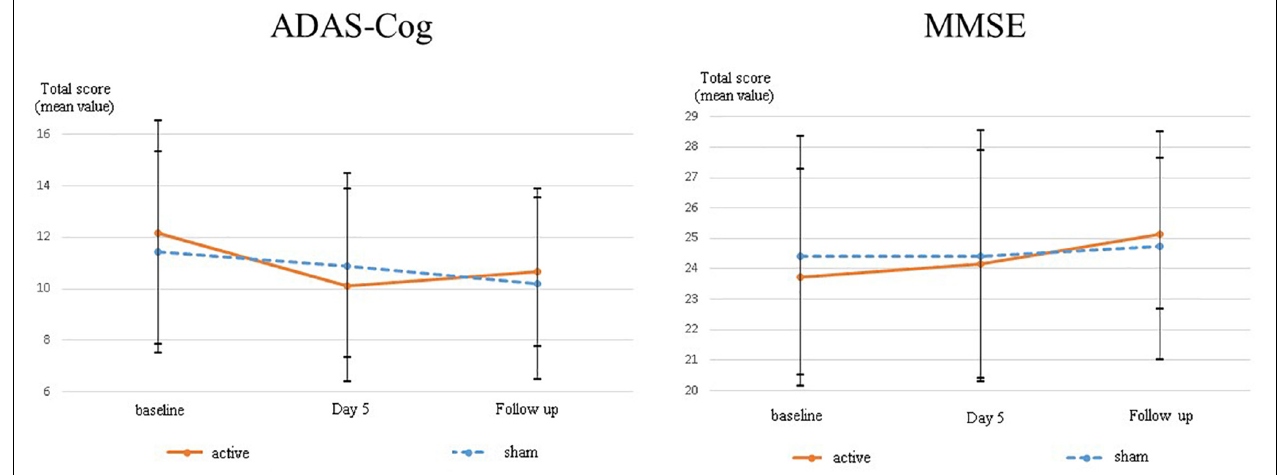
FIGURE 3 | The change scores in adjusted mean difference from baseline on ADAS-Cog and MMSE. In order to understand the mean change from baseline in each group easily, baseline scores in each group were shown as zero in this graph.